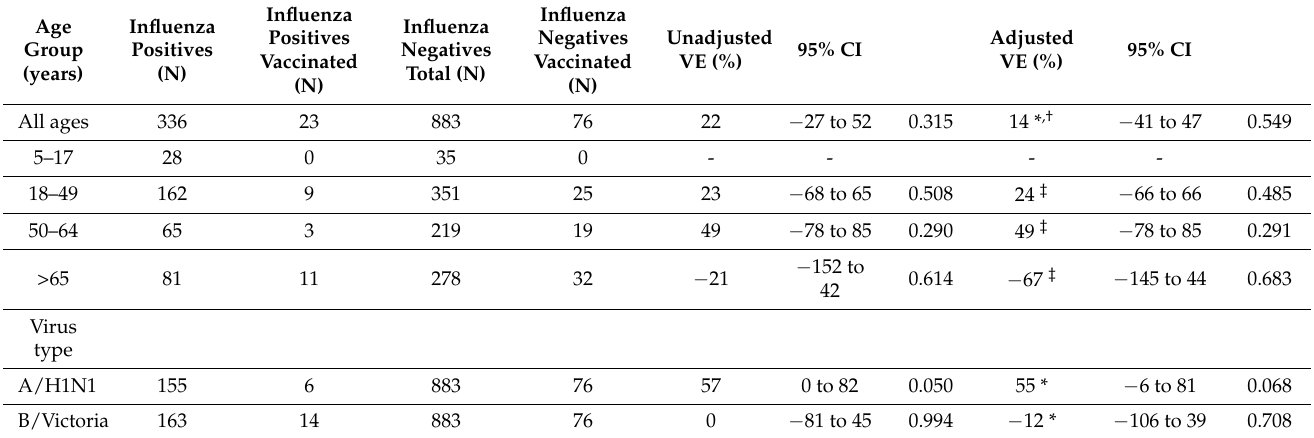
Table 2. Vaccine effectiveness against the trivalent influenza vaccine for the season 2019–2020 among different age groups. Age